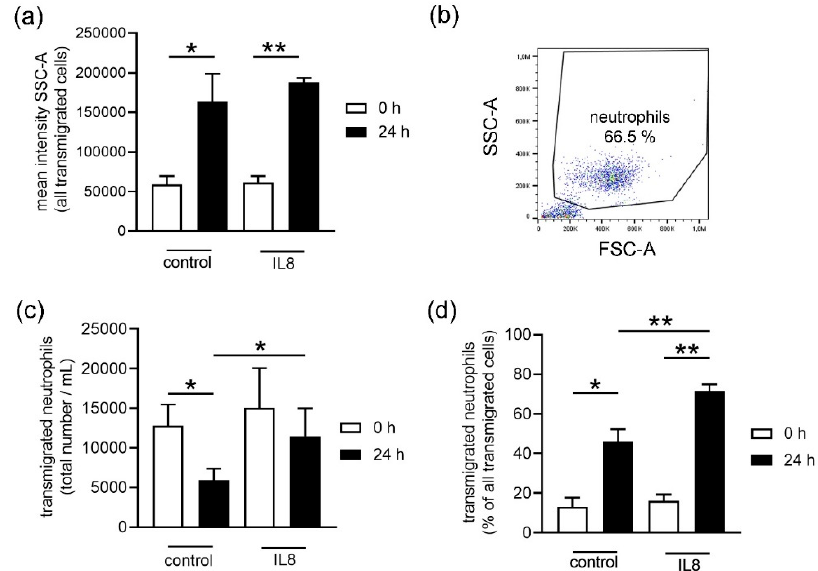
Figure 4. Neutrophil transmigration from whole blood was analyzed after 4 h incubation. ( a ) The mean intensity SSC-A (granularity) of all transmigrated cells was significant different between fresh and stored blood with and without IL8 treatment. It revealed higher granularity of transmigrated cells, indicating higher activation of neutrophils after 24 h of blood storage as also confirmed by ROS production, shown in Figure 5. ( b ) The gating strategy for the analysis of transmigrated cells by flow cytometry is presented and neutrophils were identified based on FSC-A and SSC-A. ( c ) Neutrophils from stored blood transmigrated less than neutrophils from fresh blood. The IL8 stimulated transmigration was only significantly increased in stored blood. ( d ) Observing the whole transmigrated cellular population, the percentage of neutrophils is significantly higher in stored blood. Data were analyzed with one-tailed paired Student’s t -test (all assays were conducted in triplicates, and the mean is presented from n = 3 independent runs) and presented with mean ±SD (* p < 0.05, ** p < 0.01).